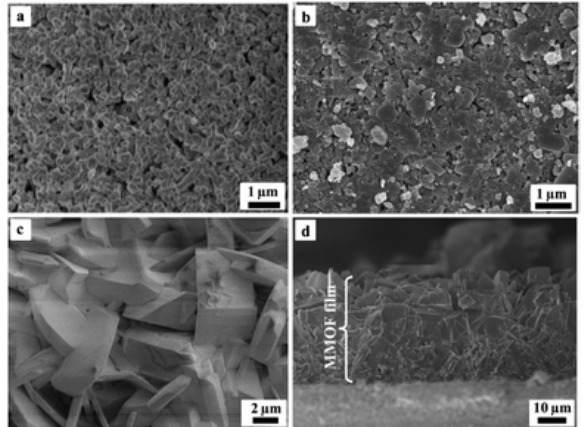
Figure 8. SEM images at different stages of MOF membrane growth: ( a ) α -alumina support, ( b ) seed layer, ( c ) membrane (top view), and ( d ) membrane (cross-section view) (adapted with permission from ref. [90]).